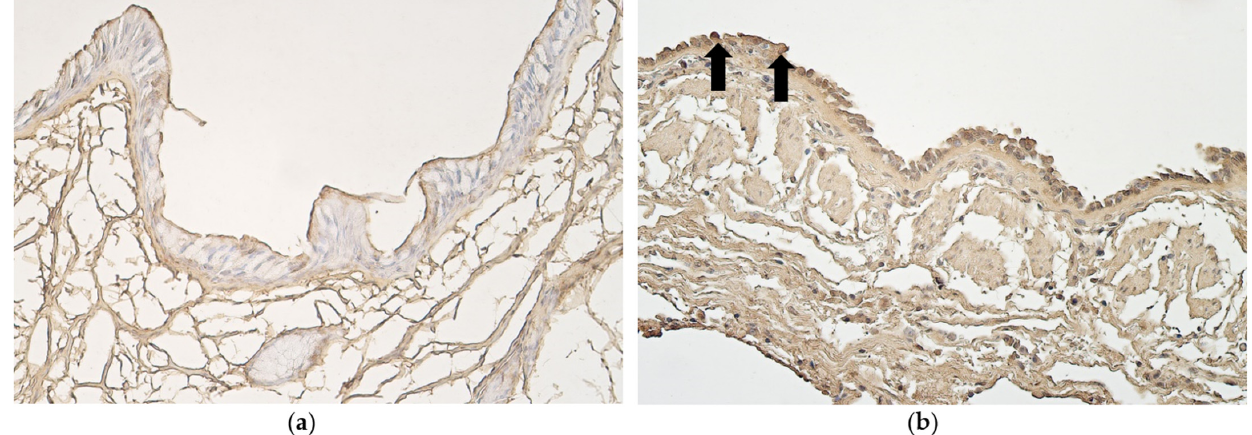
Figure 4. ( a ) No apoptotic cells in non-changed bronchial epithelium of a 54-year-old male. TUNEL, X200. ( b ) Few apoptotic cells in a 93-year-old male with partially detached metaplastic bronchial epithelium (arrows). TUNEL, X200.